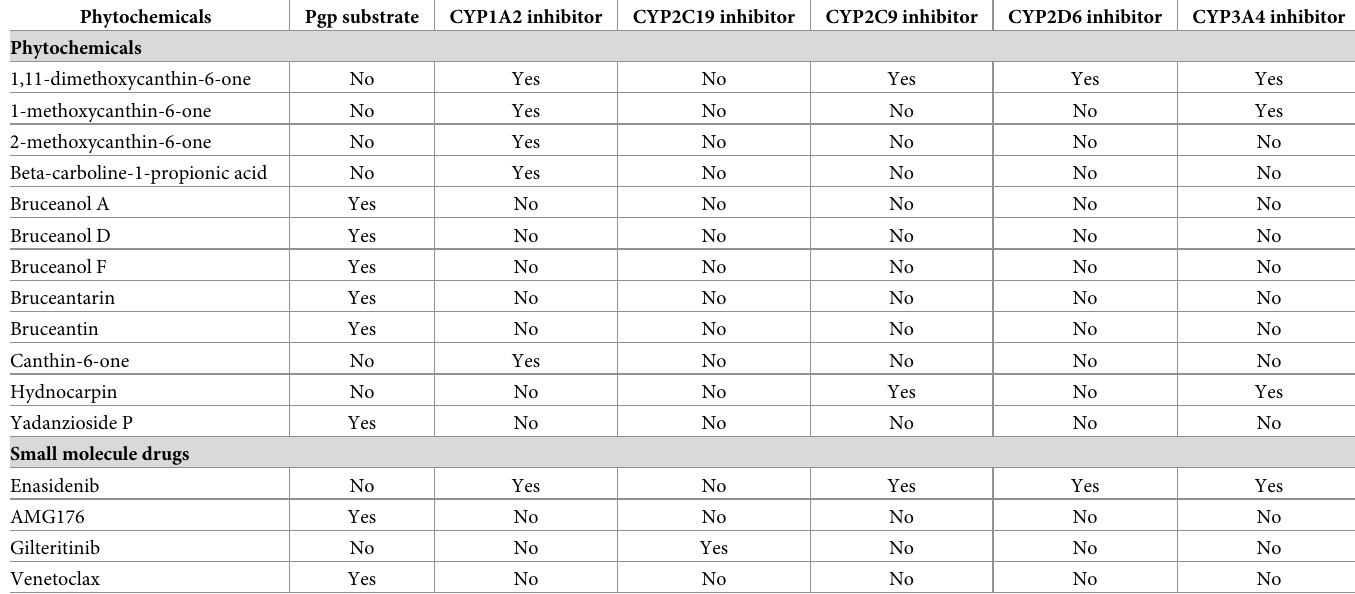
Table 4. Interaction of selected B . antidysentrica phytochemicals and small molecule modern drugs with P-glycoprotein and cytochrome P450 isoenzymes.